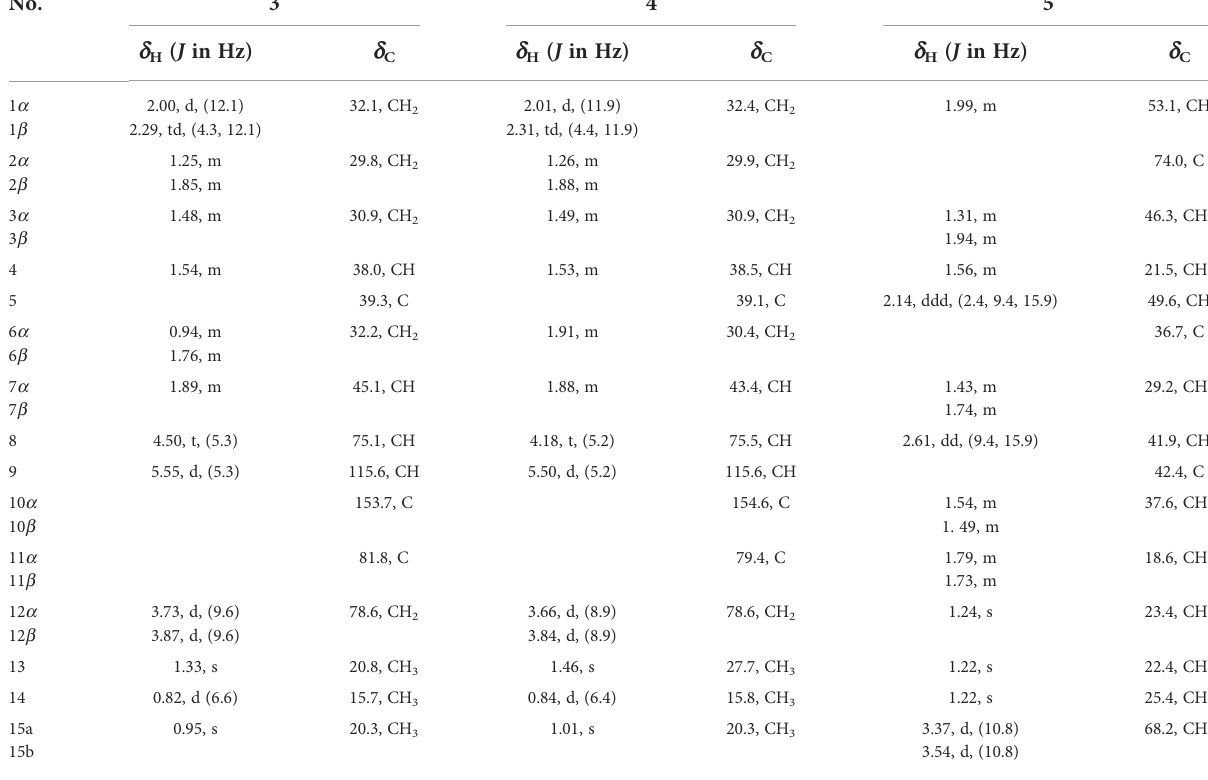
TABLE 3 1 H (500 MHz) and 13 C NMR (125 MHz) data of 3 – 5 in CDCl 3 ( d in ppm, J in Hz).